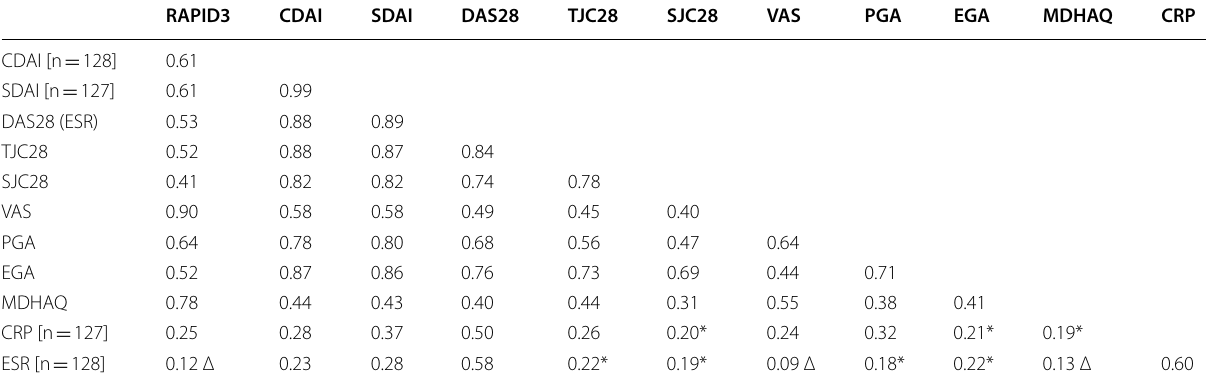
Table 2 Inter-component correlation coefficients (Spearman’s